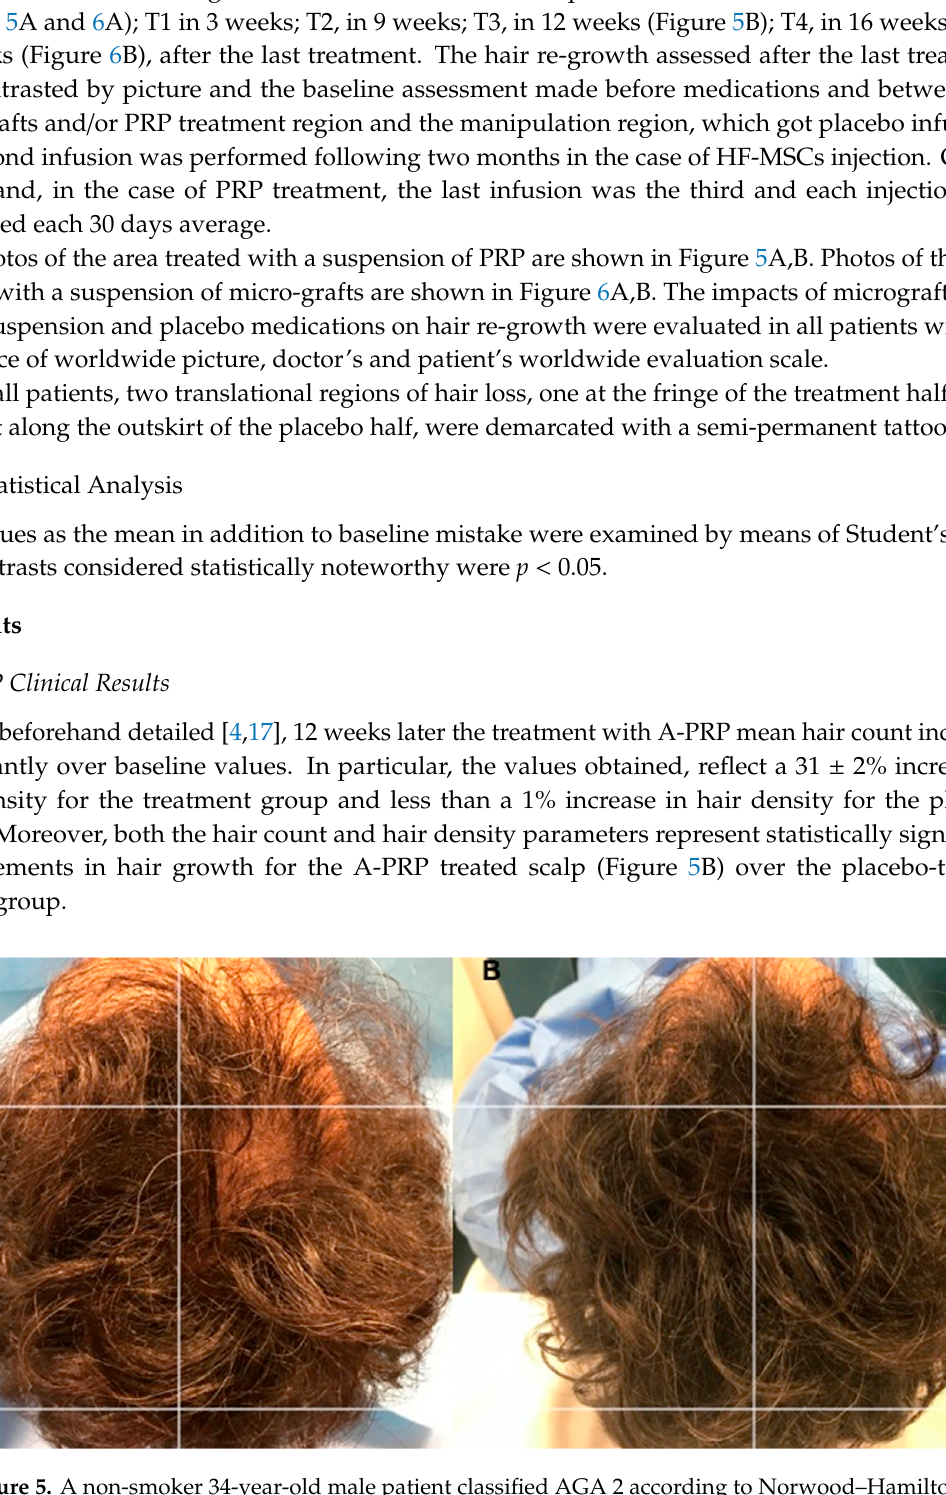
Figure 5. A non-smoker 34-year-old male patient classified AGA 2 according to Norwood–Hamilton Scale. ( A ) Timing T0 (before the treatment) with hair loss localized to the vertex, parietal, temporal, and frontal areas; ( B ) Timing T3 after 12 weeks later the last third treatment with increase of hair density in the right parietal area treated with three autologous platelet-rich plasma not activated (A-PRP) injections versus left parietal area treated with placebo.